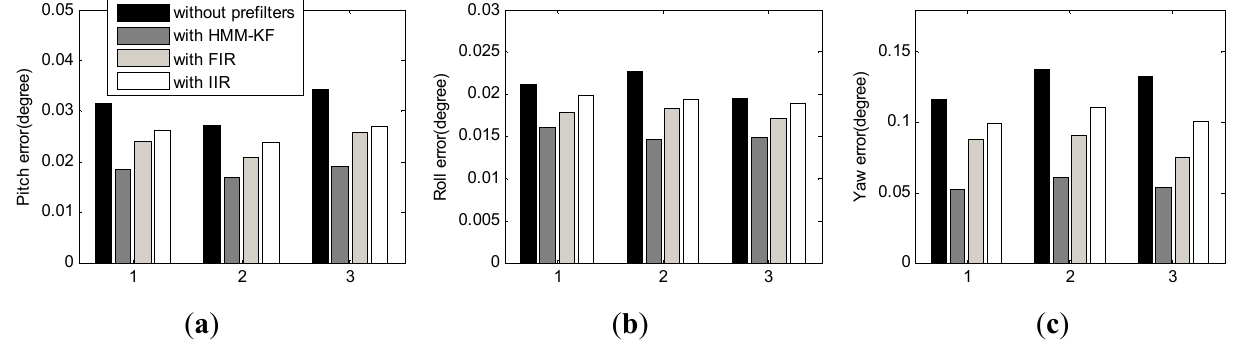
Figure 15. Comparison of the misalignment angles using the four alignment schemes.